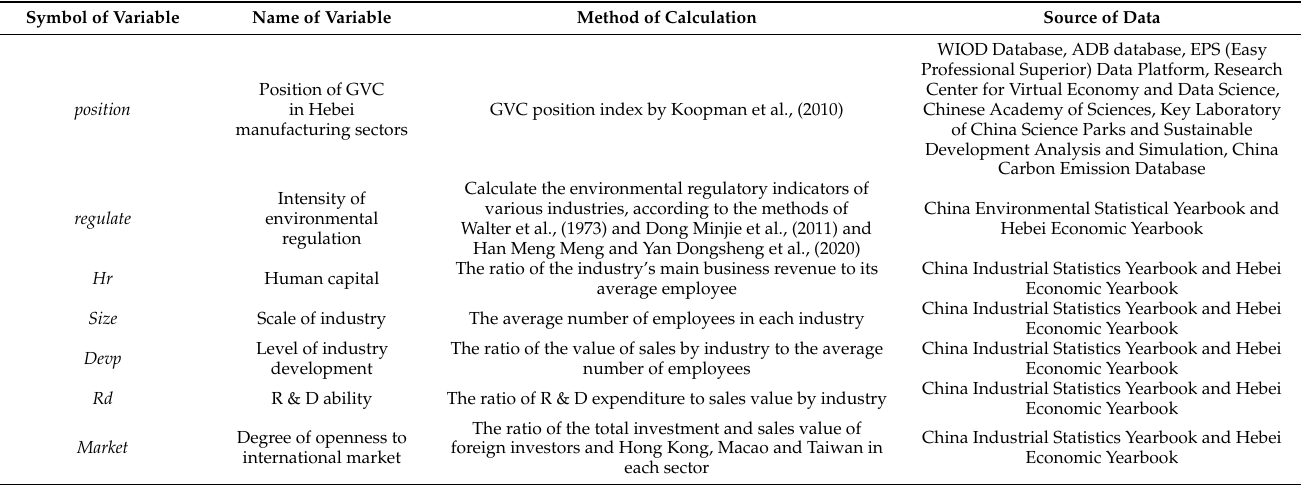
Table 1. Description of variables and data sources.